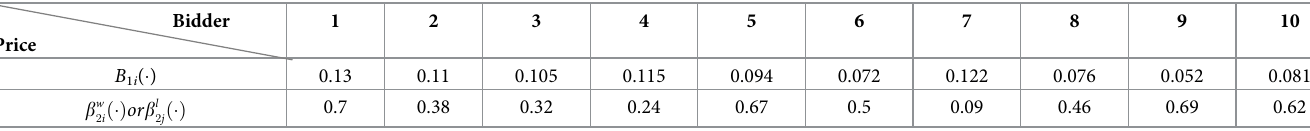
for this phenomenon is that when R is high, the additional cost for the loser who obtains the land during the second stage increases in the future. Thus, the loser pays a higher cost if they acquire the land and is willing to pay less for the construction land auction. Fig 4 shows that the parameter of land price depreciation negatively affects the losers’ value of the construction land. Figs 2–4 illustrate Propositions 2 and 3. ers. Figs 5 and 6 are drawn using the equilibrium conditions and by calculating expressions. The farmers’ expected income increases with the increase in the fine on delaying construc- tion and decreases with the increase in the revenue loss of bidders losing during the second increases and decreases with the increase in the fine and revenue loss, respectively, that is, the fine of delaying construction and repurchasing the quota at a premium from the bidder who acquires the quota but fails to obtain the land set by local governments indirectly affects the income of farmers who reclaim idle homesteads. Therefore, the fine on delaying construction